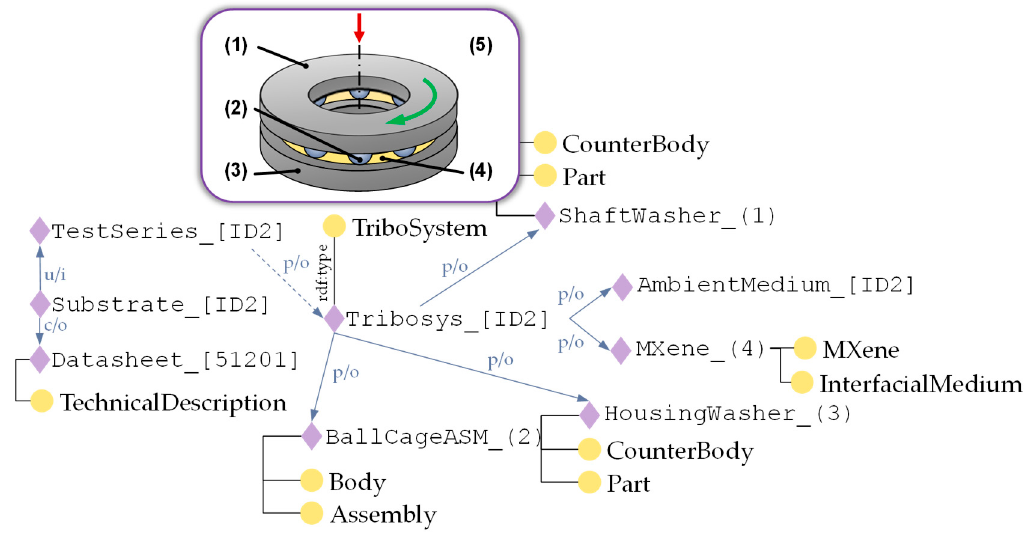
Figure 12. Formal definition of the tribosystem studied in the component test.